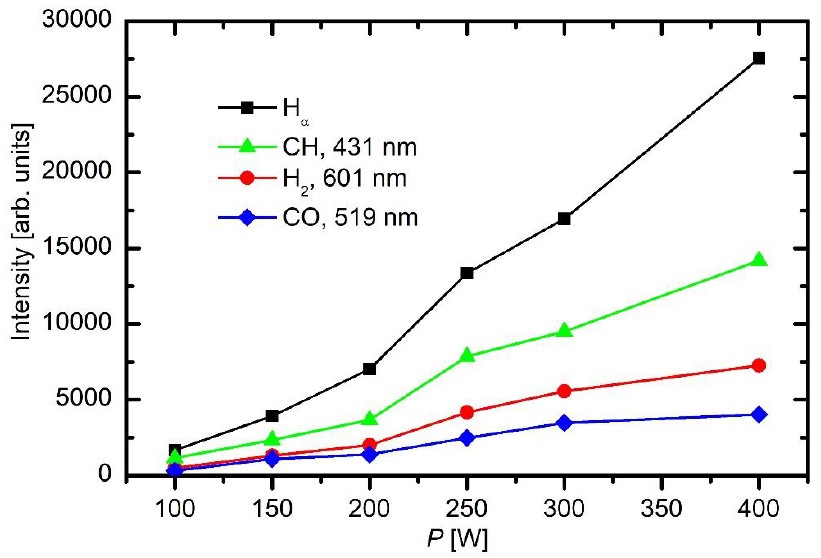
Figure 6. Intensities of some spectral features versus RF power in HMDSO plasma at 5 Pa. As expected, all spectral features increase with increasing power. This is explained by higher electron density and temperature at elevated powers. The di ff erences between the lowest power (100 W) and highest (400 W) are huge. For example, the height of the H α peak at 400 W is over an order of magnitude larger than at 100